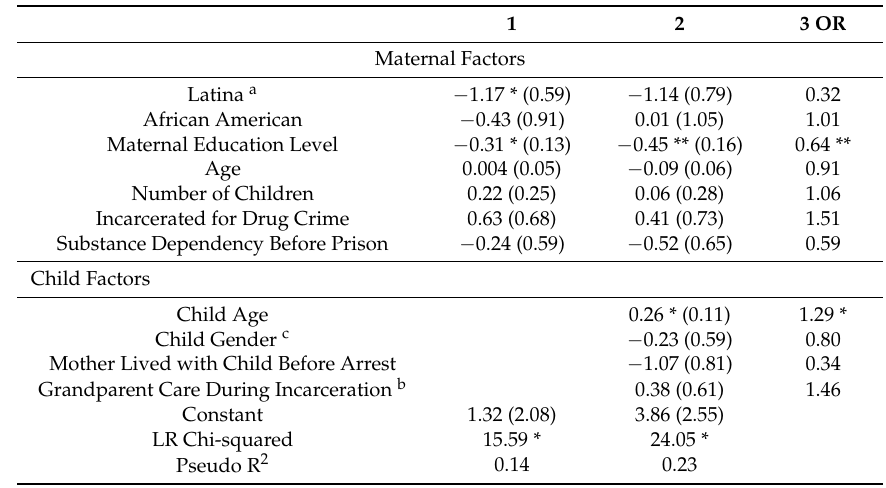
Table 2. Logistic regression of minor siblings living apart during maternal incarceration on